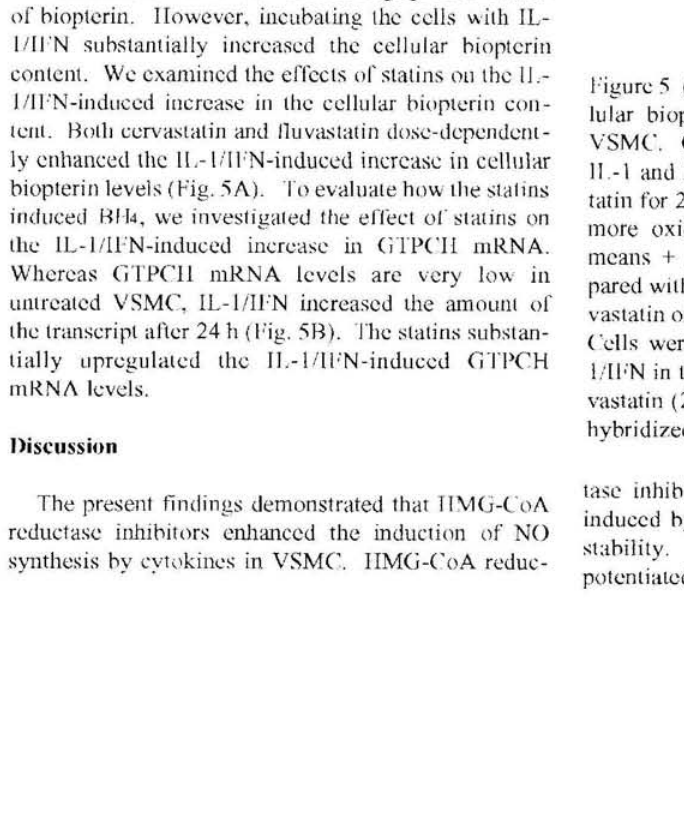
Figure 4 (A) Kffect of cervastatin or fluvastatin on iNOS mRNA expression in IL-l/lJr'N-stimulated rat VSMC. Time course of iNOS mRNA induction in rat VSMC stimulated with 1L-1TFN in the absence and presence of cervastatin or fluvastatixi. Total RNA was isolated, Northern hybridized with a rat iNOS-specific probe and 18S probe, (lì) Effect of cervastatin or flu- vastatin on iNOS gene transcription in IE-1/IFN stim- ulated rat VSMC. Nuclear run-on analysis was con- ducted 8 h after incubating rat VSMC" with 11,-1/lFN in the absence or presence of cervastatin (Ceri, S μΜ) or tluvastatin (Flu, 25 μΜ). transcription of the isolated nuclei was analyzed by hybridizing 32P-labeled RNA to iNOS and GAI'DII cDNAs immobilized on nylon membranes.